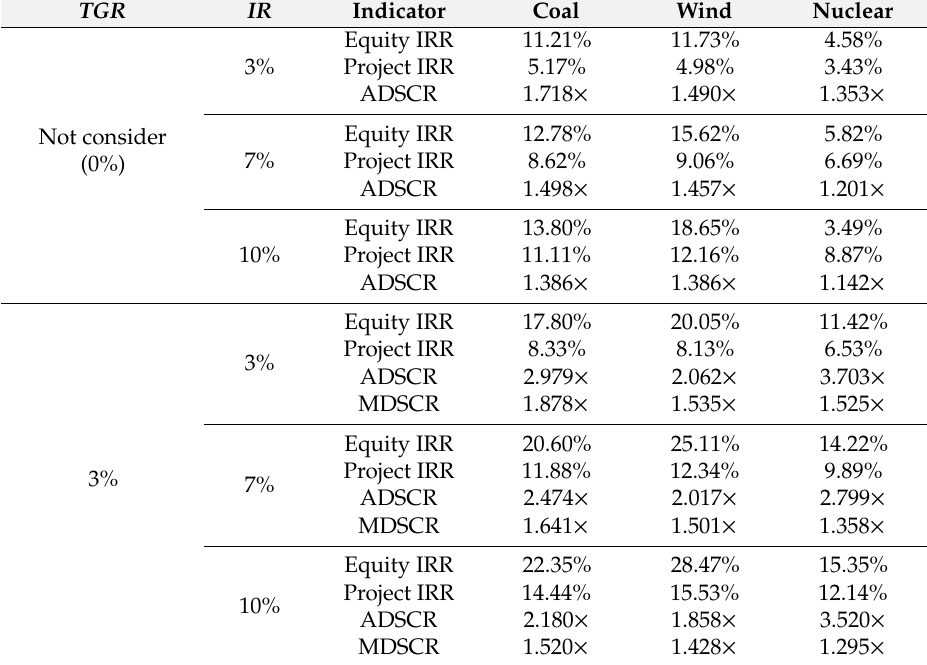
Table 8. IRR and DSCR values of Coal, Wind, and Nuclear with 0% and 3%